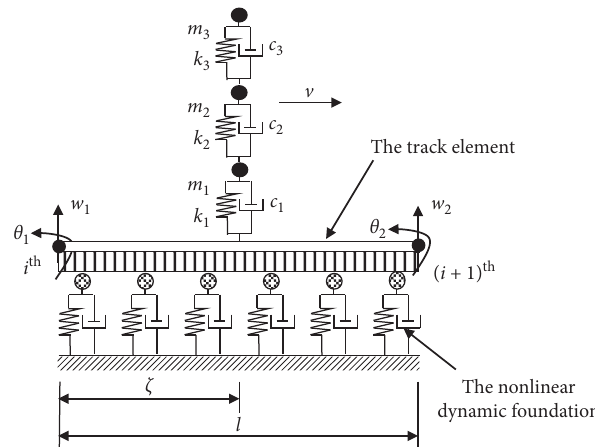
Figure 3: The track-train interaction element.